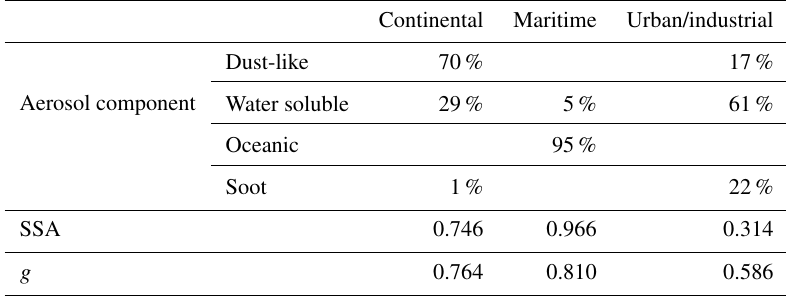
Table 2. Optical properties of three aerosol mixture models (WCRP,